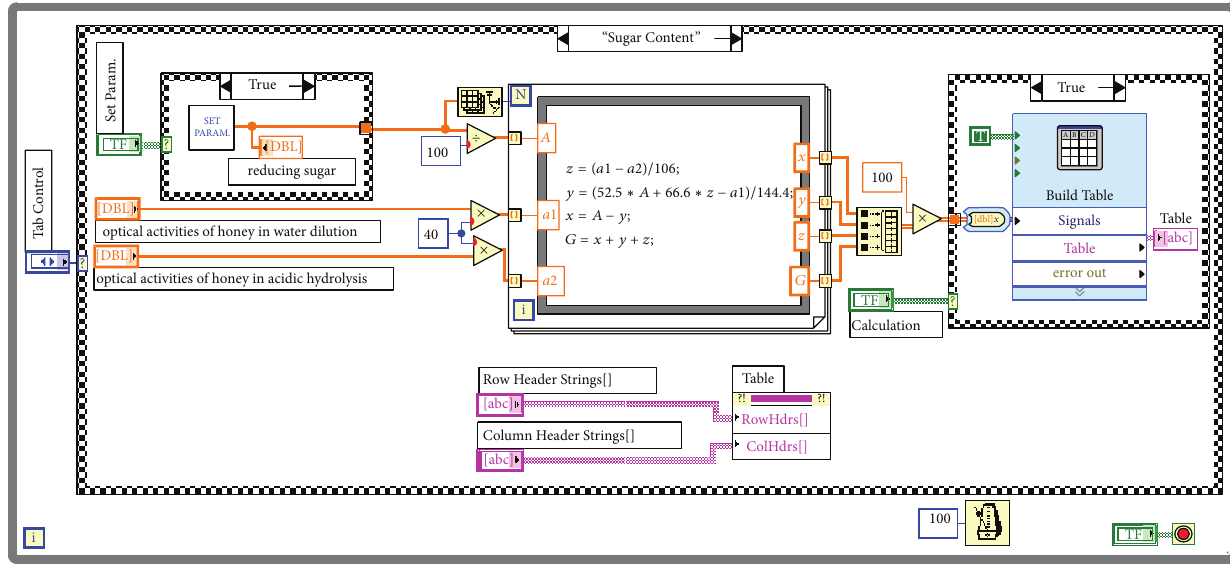
Figure 5: Program for the sugar degree analysis.